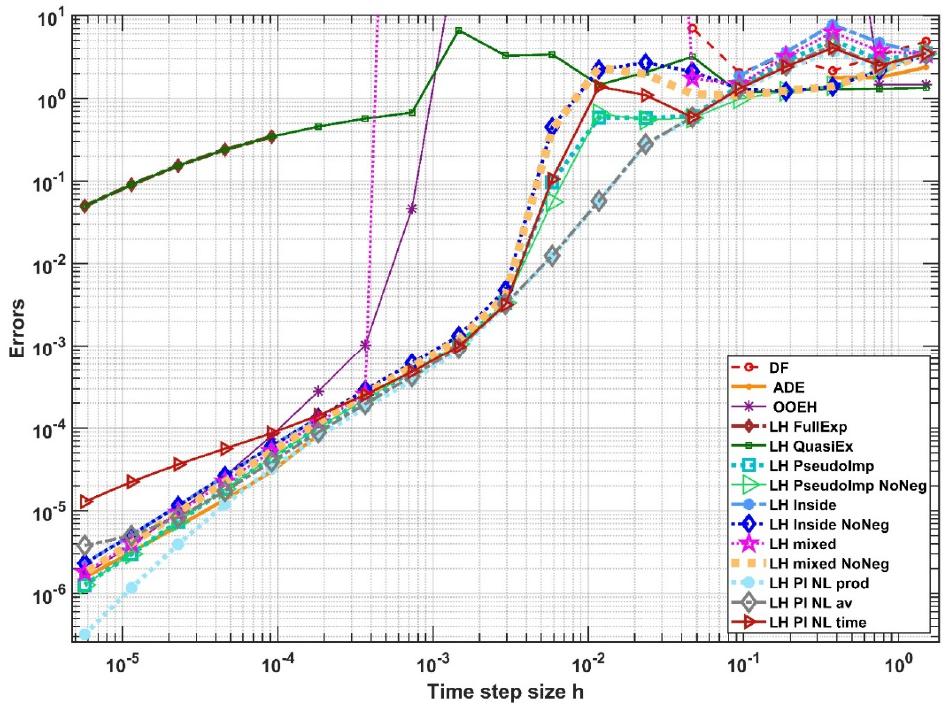
Figure 6. The L ∞ errors vs. the time step size for the numerical algorithms defined in Sections 2.3